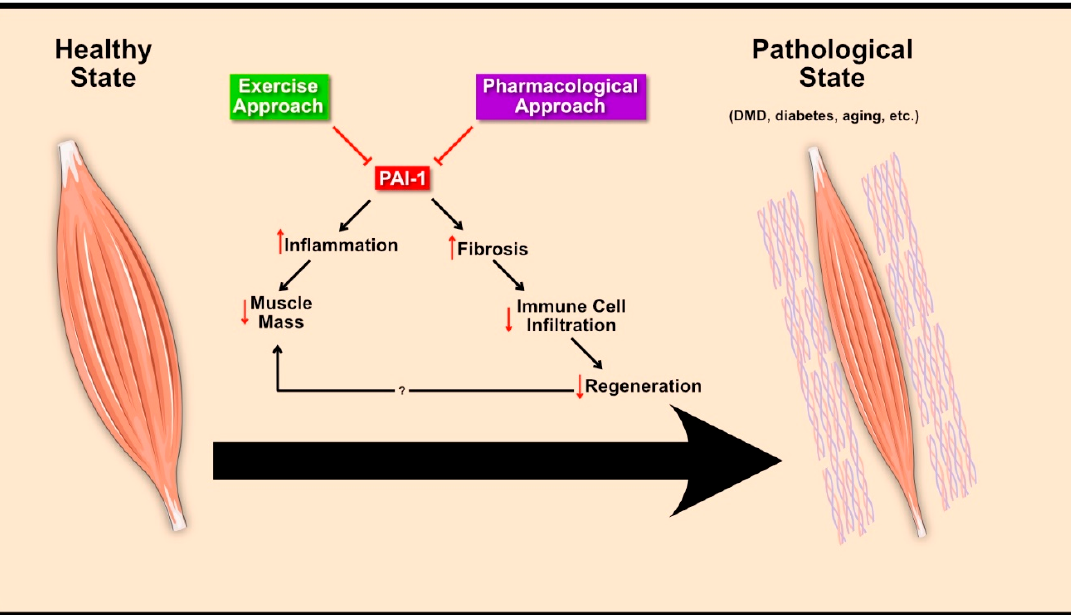
Figure 4. PAI-1 in muscle pathology and therapeutics. Excessive PAI-1 levels lead to increased fibrosis and are associated with inflammation. In skeletal muscle, this results in impaired regeneration and reduced muscle mass in various pathological states. Exercise and pharmacological agents reduce circulating PAI-1 levels and serve as a therapeutic approach to normalize PAI-1 levels and improve skeletal muscle health.